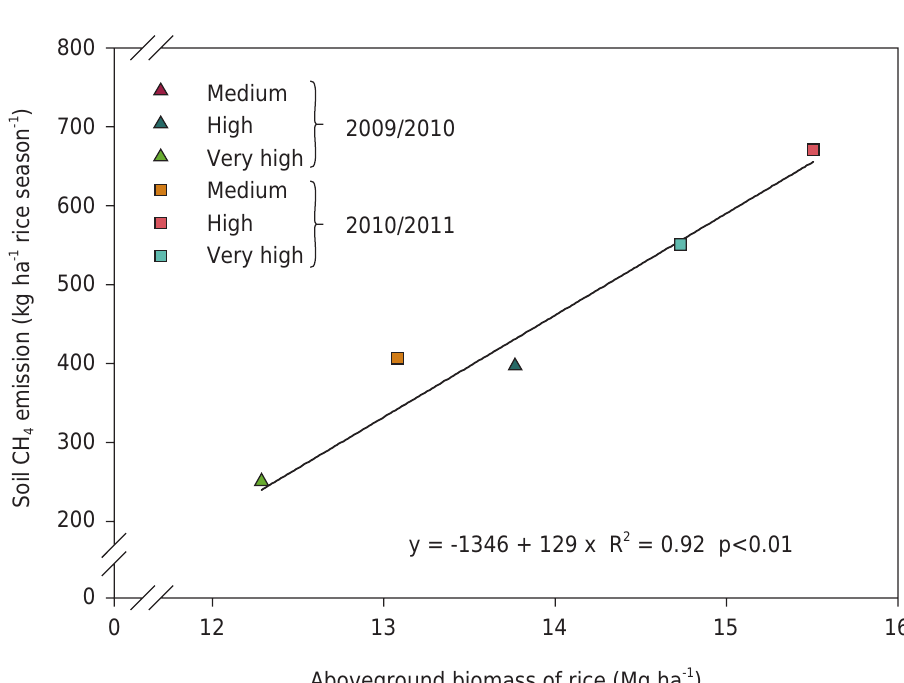
Figure 4. Relationship between aboveground rice biomass (R 4 stage) and CH 4 emissions during the rice season at different crop management levels in southern Brazil.